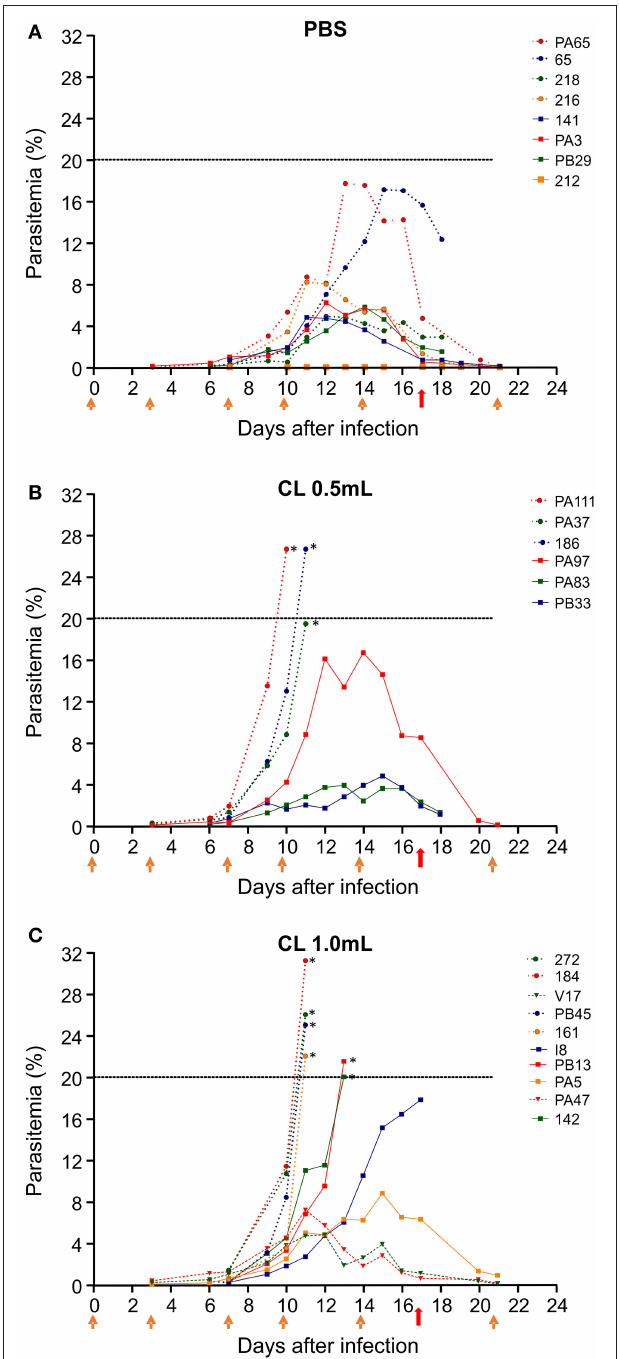
FIGURE 2 | Course of parasitemia after infection of S. sciureus with 10 6 pRBC/mL by FUP strain of P. falciparum. Parasitemia is shown for animals that received PBS (controls) (A) ; clodronate liposomes (CL) 0.5 mL (B) ; or CL 1.0 mL (C) . Data are from three separate experiments, with 6–9 animals per group. Orange arrows indicate the timepoints when PBS or CL was given to the animals. Red arrows indicate treatment with mefloquine. Dashed line represents the limit of parasitemia established for treatment (20%) with mefloquine. *Animals that received treatment with mefloquine before day 17 for reaching 20%